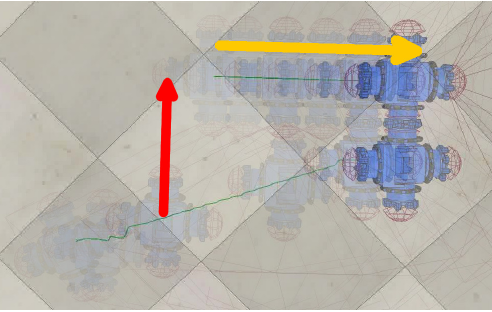
Figure 6. Docking of a robot to a moving seed, note how, while in the global reference frame, the recruited robot follows an angled path, from the reference frame of the recruiter it is simply approaching while keeping aligned to the cone’s